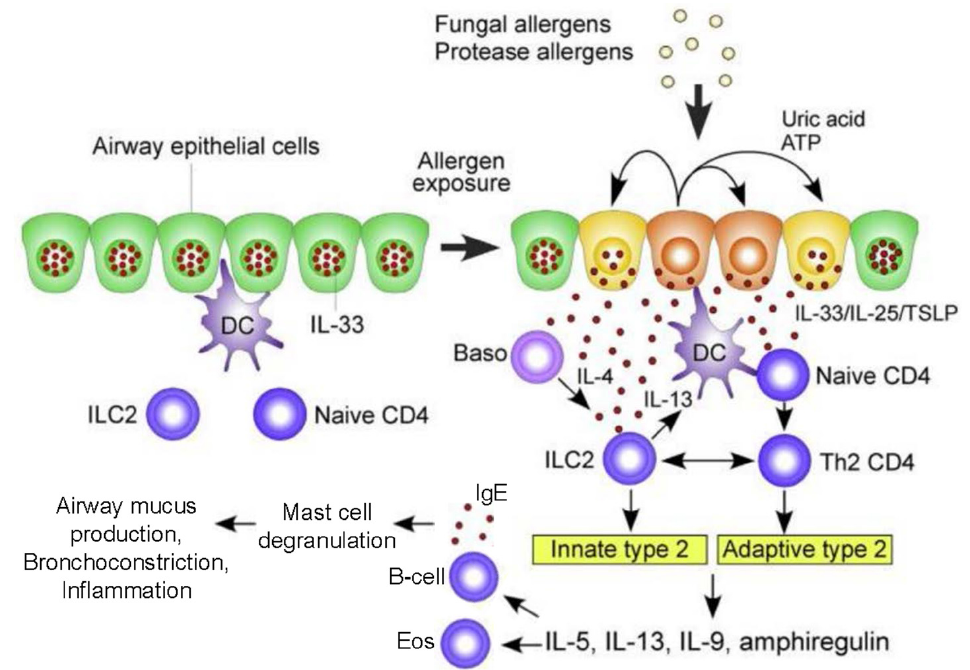
Figure 3. Immunopathogenesis of allergic bronchopulmonary aspergillosis. In the airways of susceptible people with muco-obstructive lung disease, growth of thermotolerant A. fumigatus yields pathogen-associated molecular patterns that are recognized by epithelial pattern recognition receptors of the innate arm of immunity to activate epithelium to produce alarmins and subsequently type 2 innate lymphoid cells to produce a T2-deviated cytokine response, while fungal allergens engage mucosal dendritic cells to attract and activate Th2 CD4+ cells to produce a similar T2-dominant adaptive immune response. Both arms of the T2-high immune response orchestrate IgE production, mast cell and basophil activation, and a predominantly eosinophilic luminal and mucosal inflammatory infiltrate. Source: Reference [33].